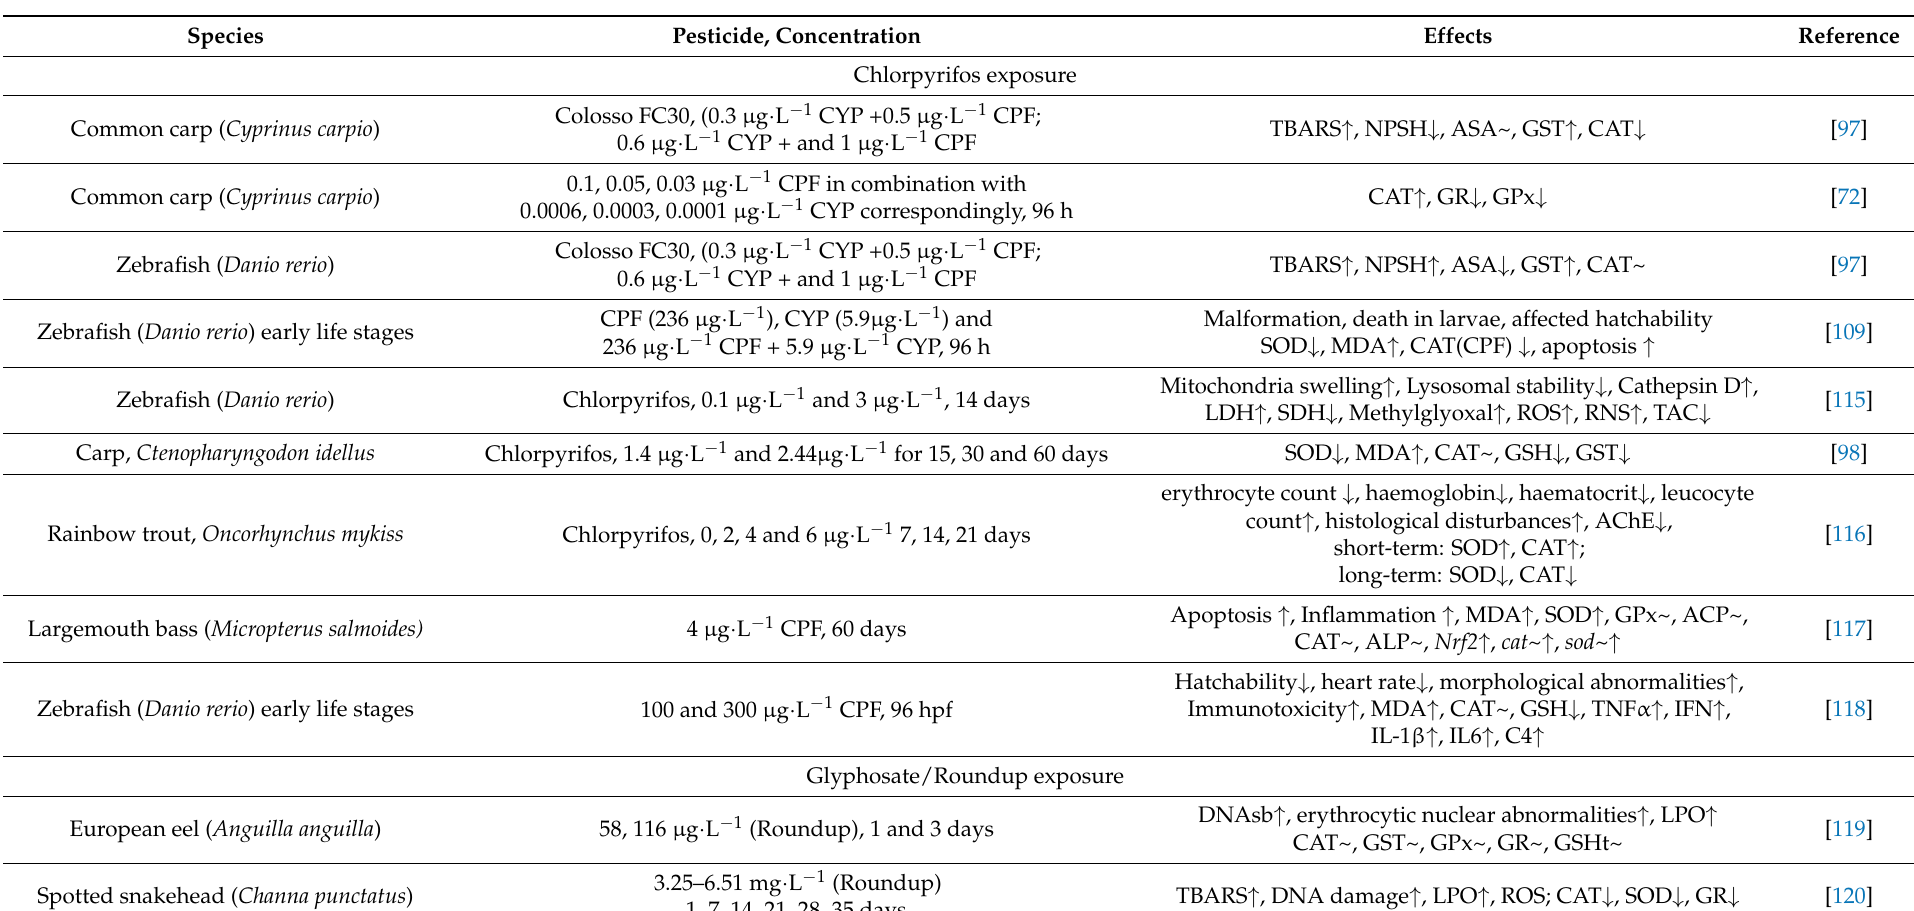
Table 1. Biochemical, physiological, and cytological alterations in fish after the effects of commonly used organophosphate pesticides.